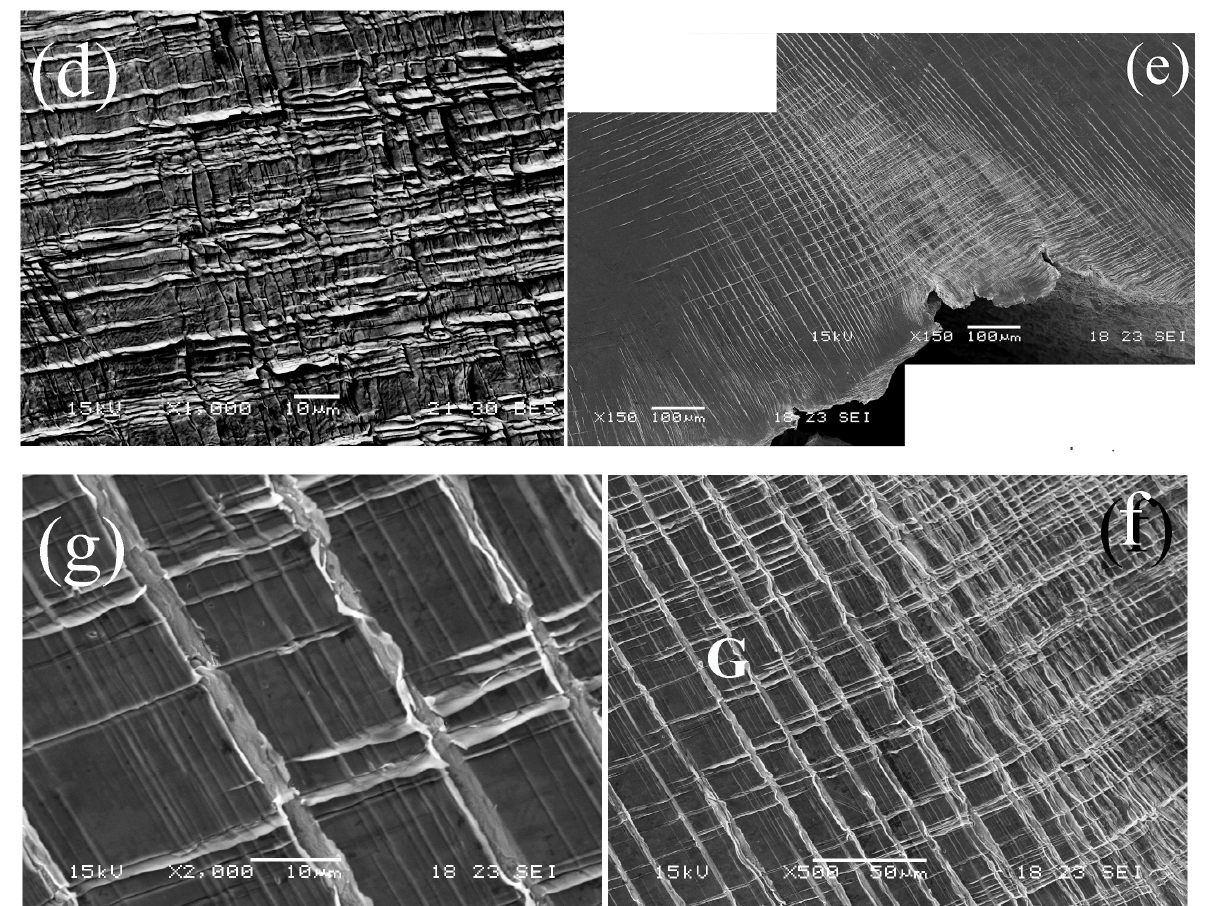
Figure 7. SEM images of the free surface of specimen 3 with a crack nearly parallel to the (100) plane. ( a ) general view, ( b ) area I, ( c ) area F, ( d ) area H, ( e ) area G, ( f ) close up in ( e ), and ( g ) area G in ( f ). The fracture surfaces were observed by optical confocal microscopy and by SEM. Figure 10a shows a transition in the fracture mode of the [110] specimen from planar propagation to a sharp ridge “zig-zag” mode (Figure 10b). In the planar area, lamellae- like brittle fatigue striations were revealed (Figure 10d). The fracture surface of the (100) specimen is planar with well-developed ductile striations (Figure